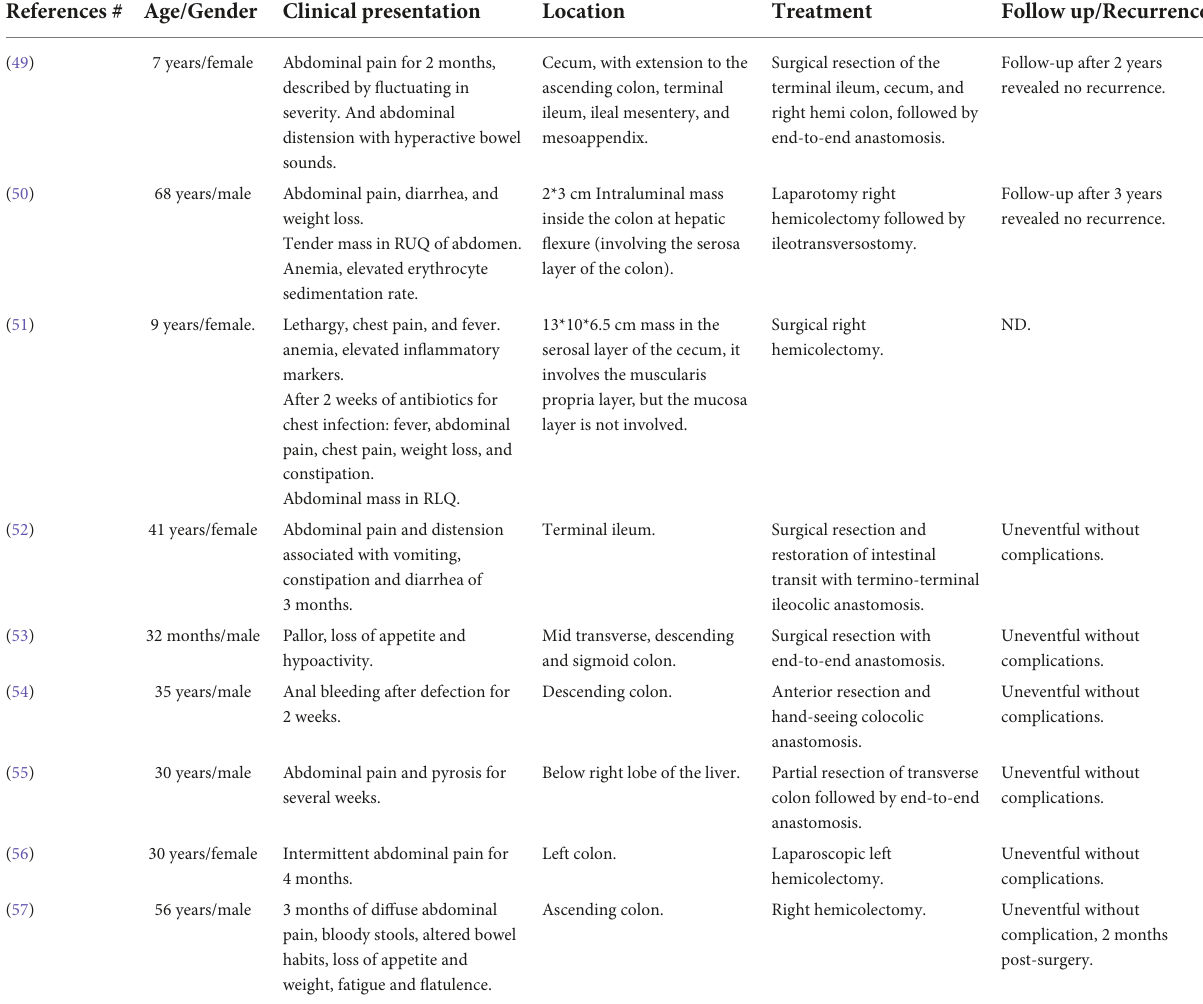
TABLE 4 Clinical features of the reported cases of inflammatory myofibroblastic tumor of the